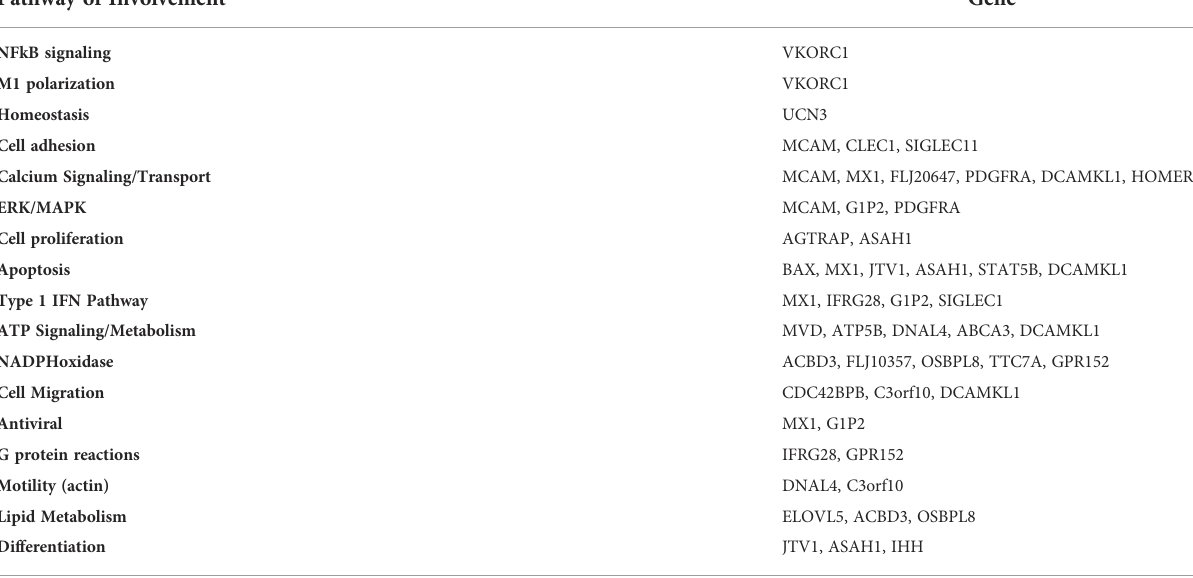
TABLE 4 Gene Pathway of Involvement. Using pathway databases, we identi fi ed pathways of involvement for each of the genes. Pathway of Involvement